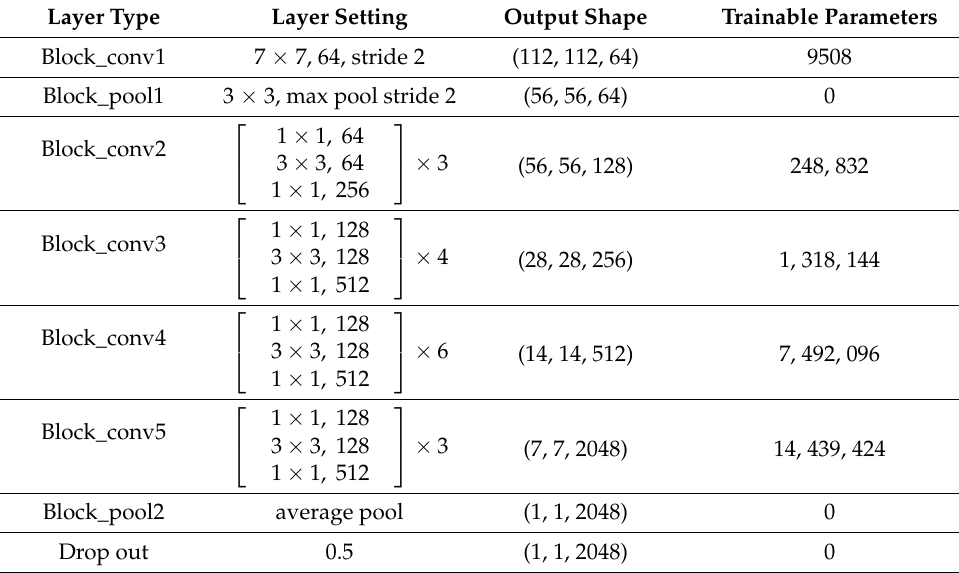
Table 1. ResNet50 structure.